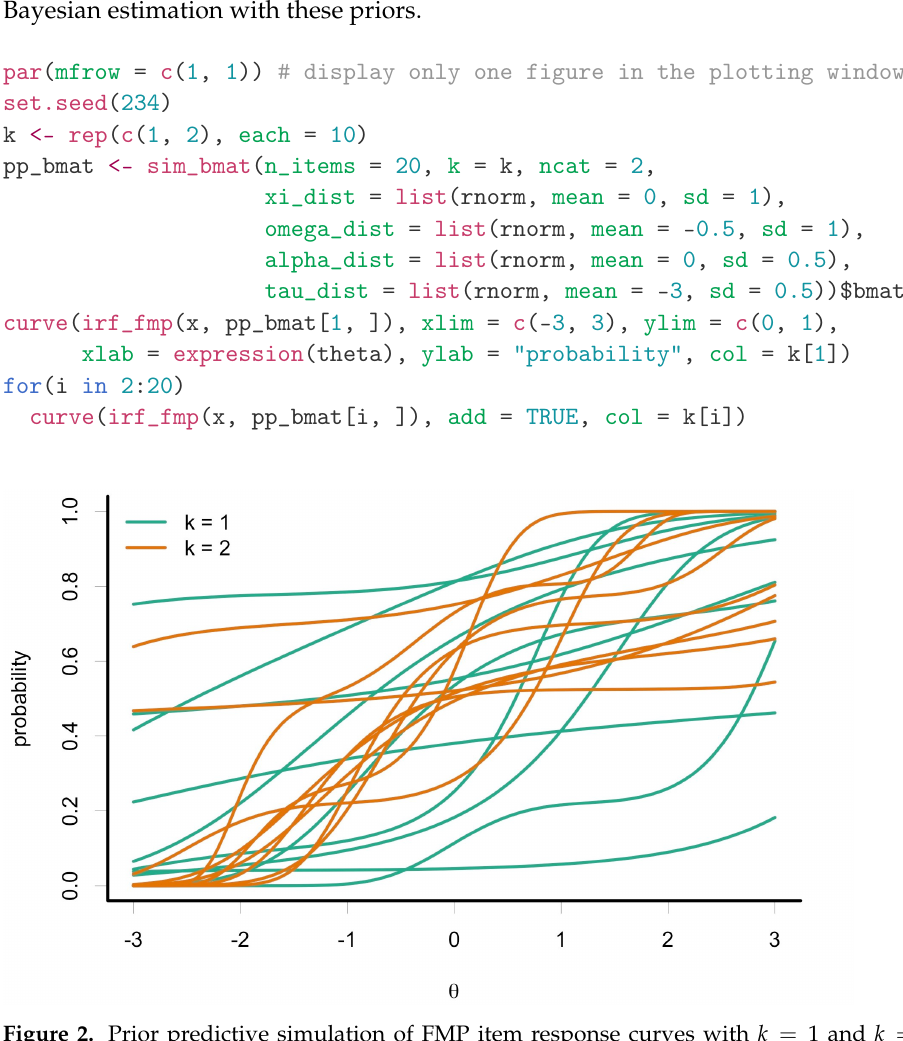
Figure 2. Prior predictive simulation of FMP item response curves with k = 1 and k = 2